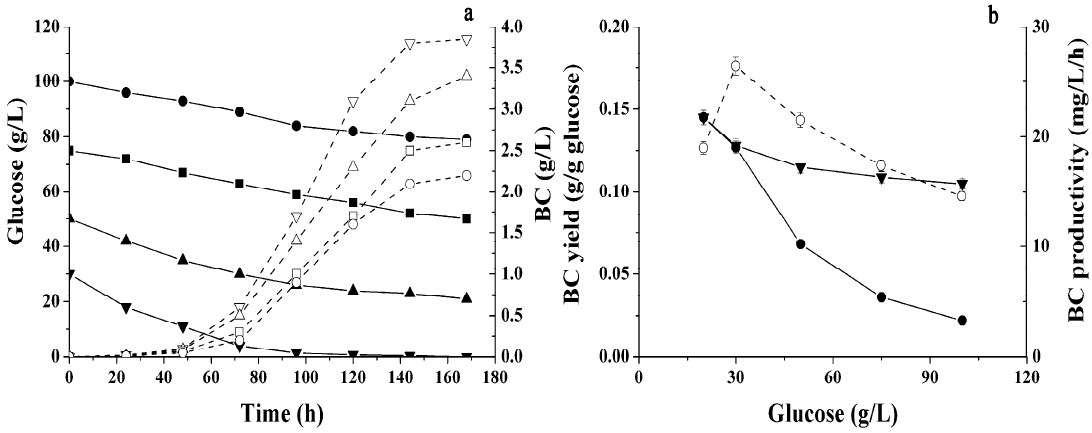
Figure 4. The kinetics of glucose consumption and BC production by immobilized Komagataeibacter xylinum B ‐ 12429 cells in the HS ‐ medium with different glucose concentrations (g/L): ▼ − 30, ▲ − 50, − 75, − 100 ( a ). The BC output depending on the concentration of glucose consumed ( ), the BC output depending on the initial glucose concentration ( ) and the rate of BC accumulation ( ) by immobilized cells depending on the initial glucose concentration in the medium ( b ).